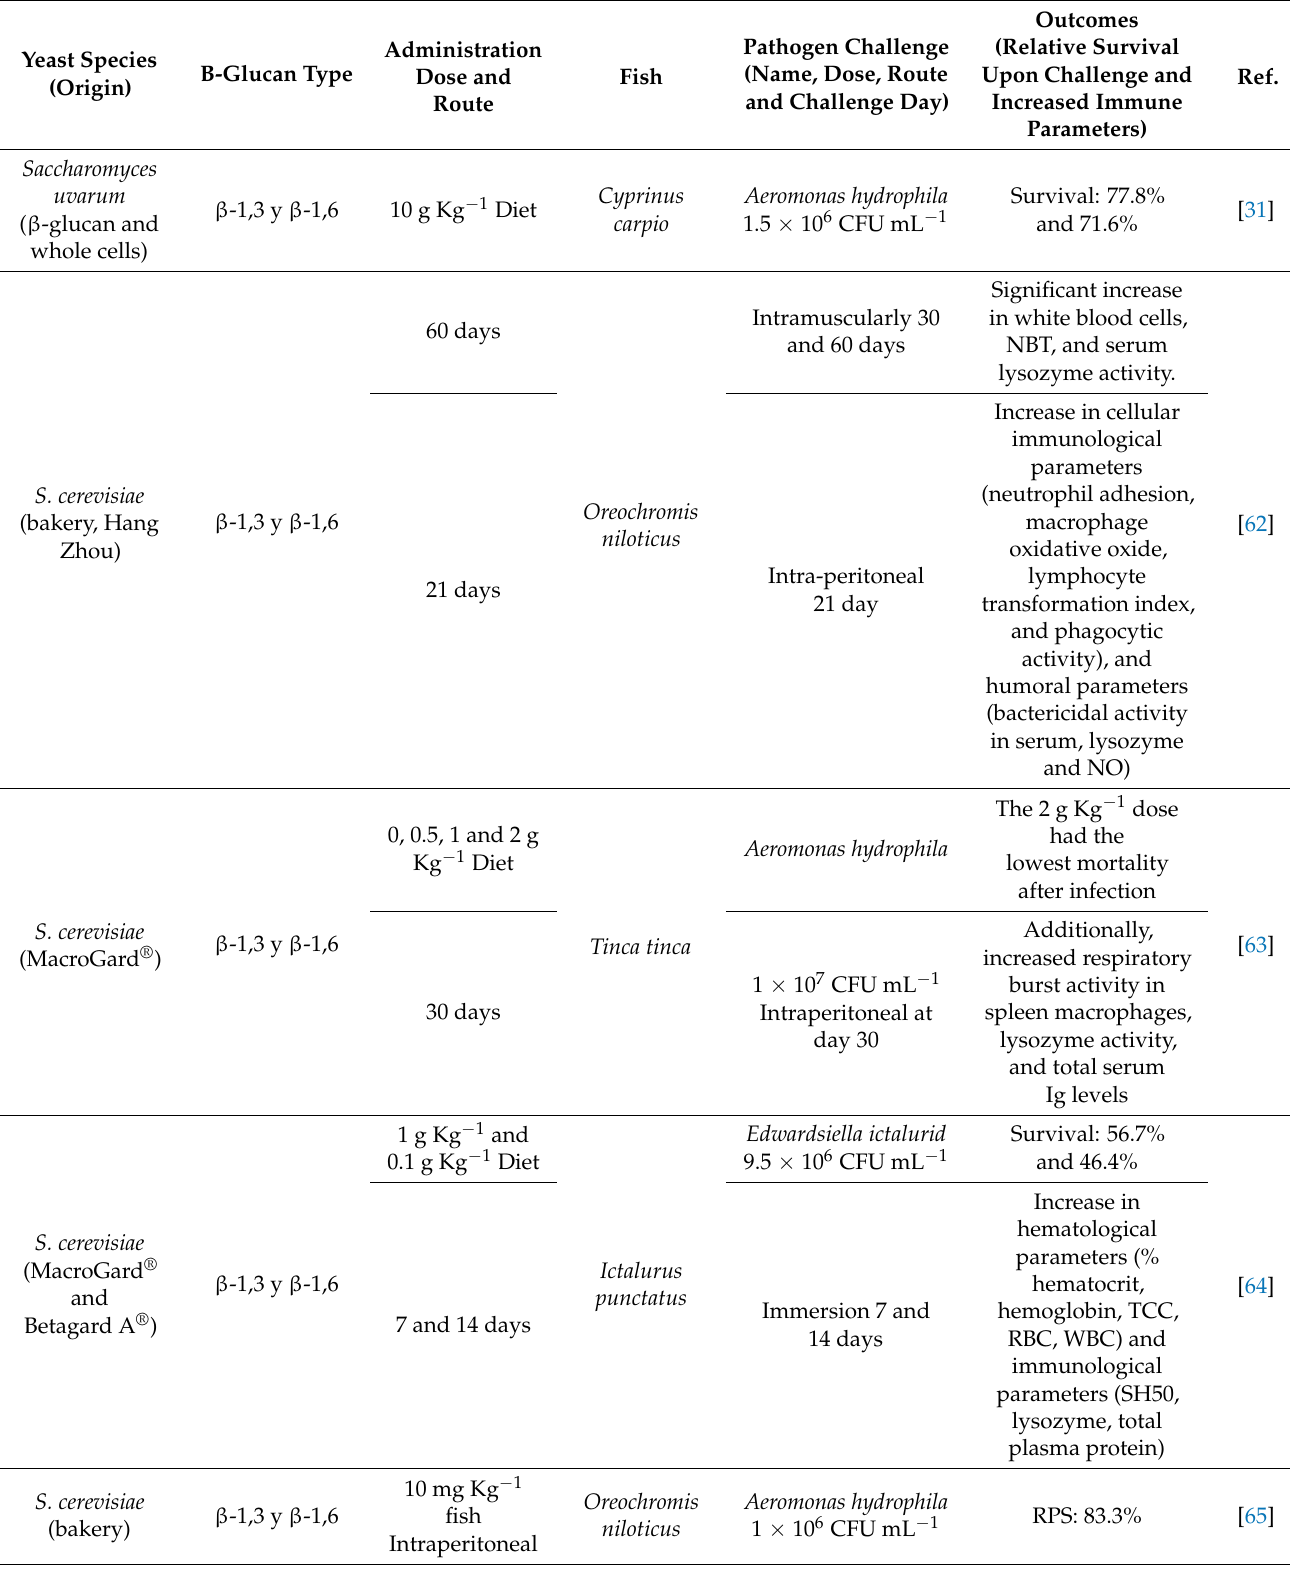
Table 2. In vivo effects of yeast β -glucans on the immune systems of different species of freshwater